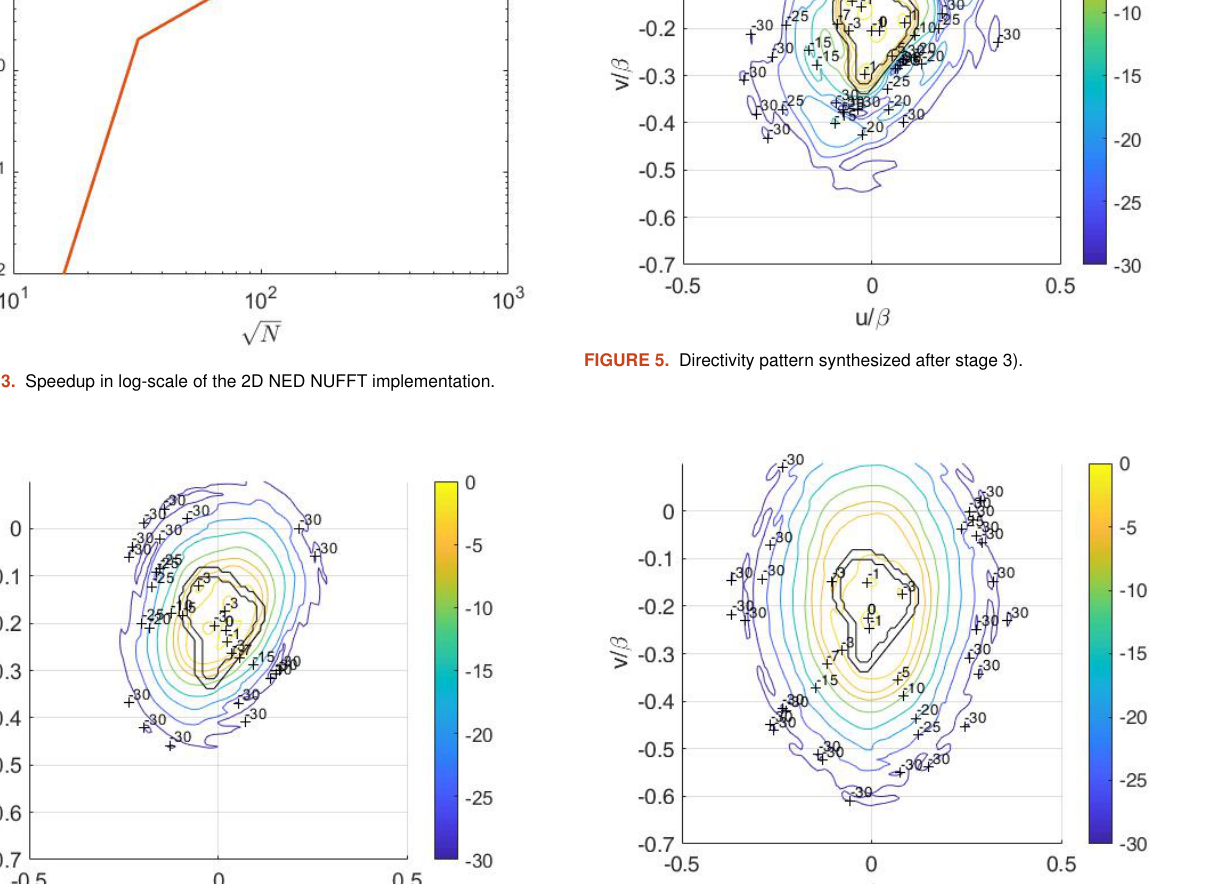
FIGURE 4. Directivity pattern synthesized by the PSO.